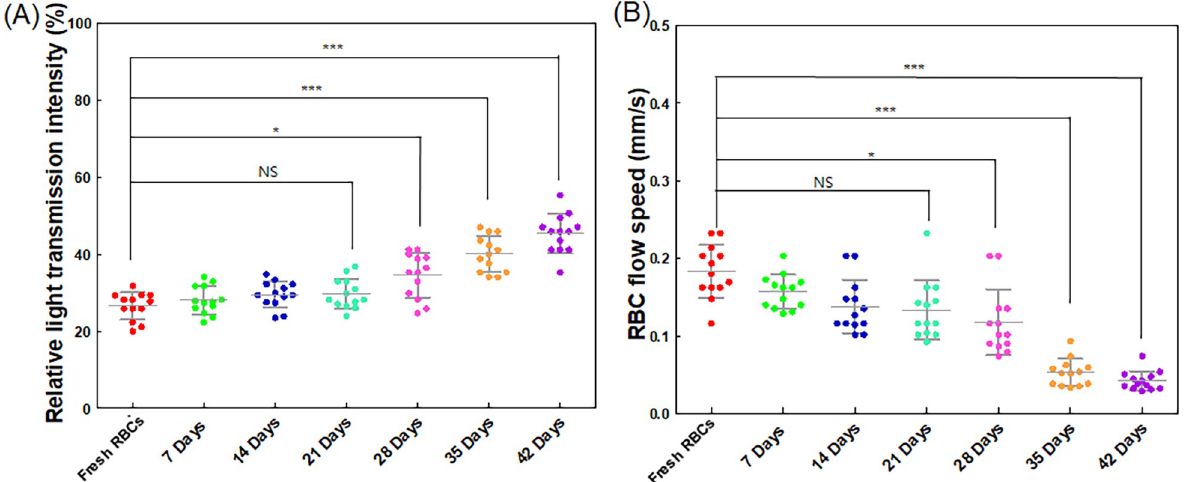
Fig 4. Relative light transmission intensity and RBC flow speed analysis with respect to storage duration. (A) Relative light transmission intensities of stored RBCs with respect to storage duration. The relative light transmission intensity was calculated from l t (cid:0) l b a series of speckle image. ( l t : transmitted light intensity, l b : background light intensity); (B) RBC flow speeds of stored RBCs in the region of interest (ROI). The speeds were measured from the ROI starting position to the end of the channel in the ROI for stored RBCs ( n = 13). NS: no significant difference, � : p < 0.05 and �� 0 . 05 < p < 0.001, ��� : p < 0.001, l